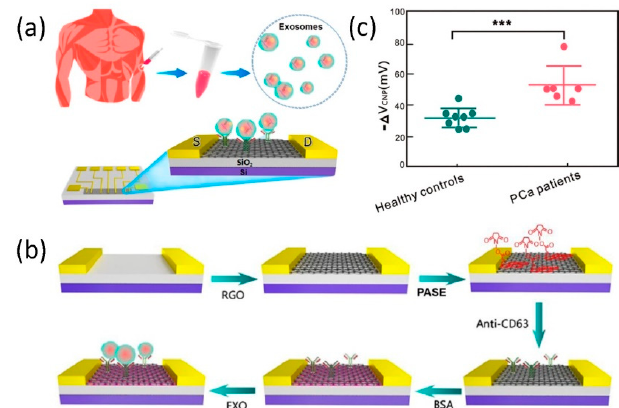
Figure 6. ( a ) Schematic illustration of the rGO FET-based sensor for the detection of exosomes. ( b ) The diagram of the process of detecting exosomes through rGO FET-based sensors. ( c ) The expression levels of di ff erent exosomes in serum correspond to healthy individuals and cancer patients. Reproduced from [97] with the permission from American Chemical